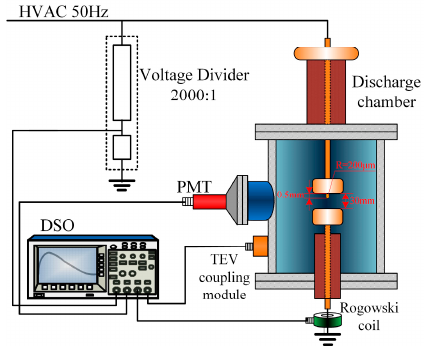
Figure 6. Schematic diagram of the PD measurement system.